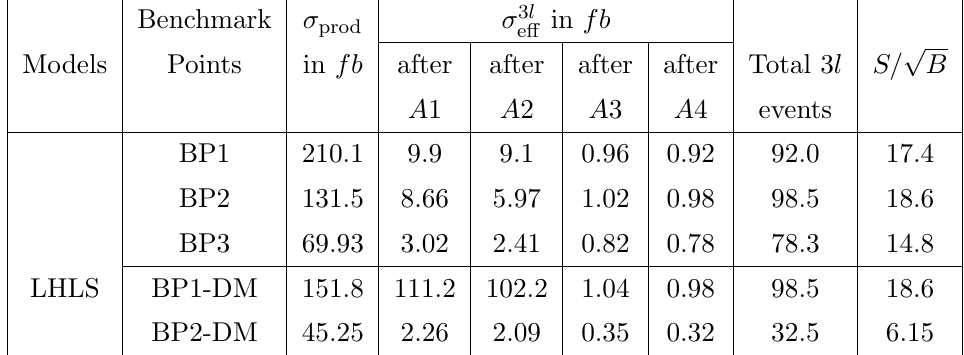
for the BPs de(cid:12)ned in p e(cid:11) B are shown for an integrated